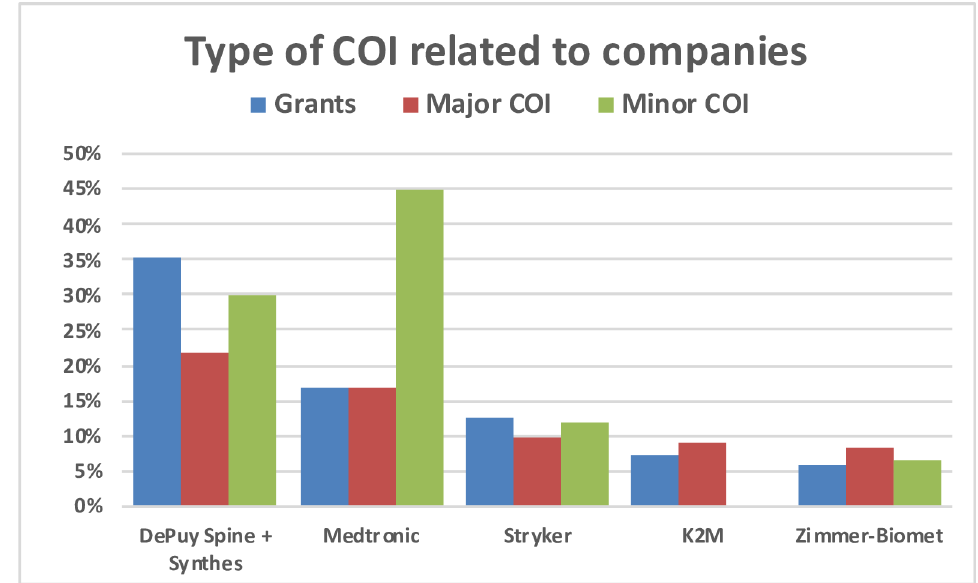
Fig 9. Overall distribution of COIs disclosed by the reviewers and related to the five leading